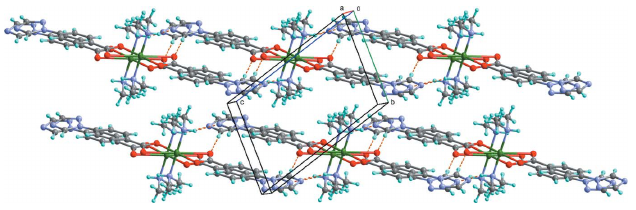
Figure 2 The crystal packing of the complex molecules. Hydrogen-bonding interactions are shown as dashed lines.